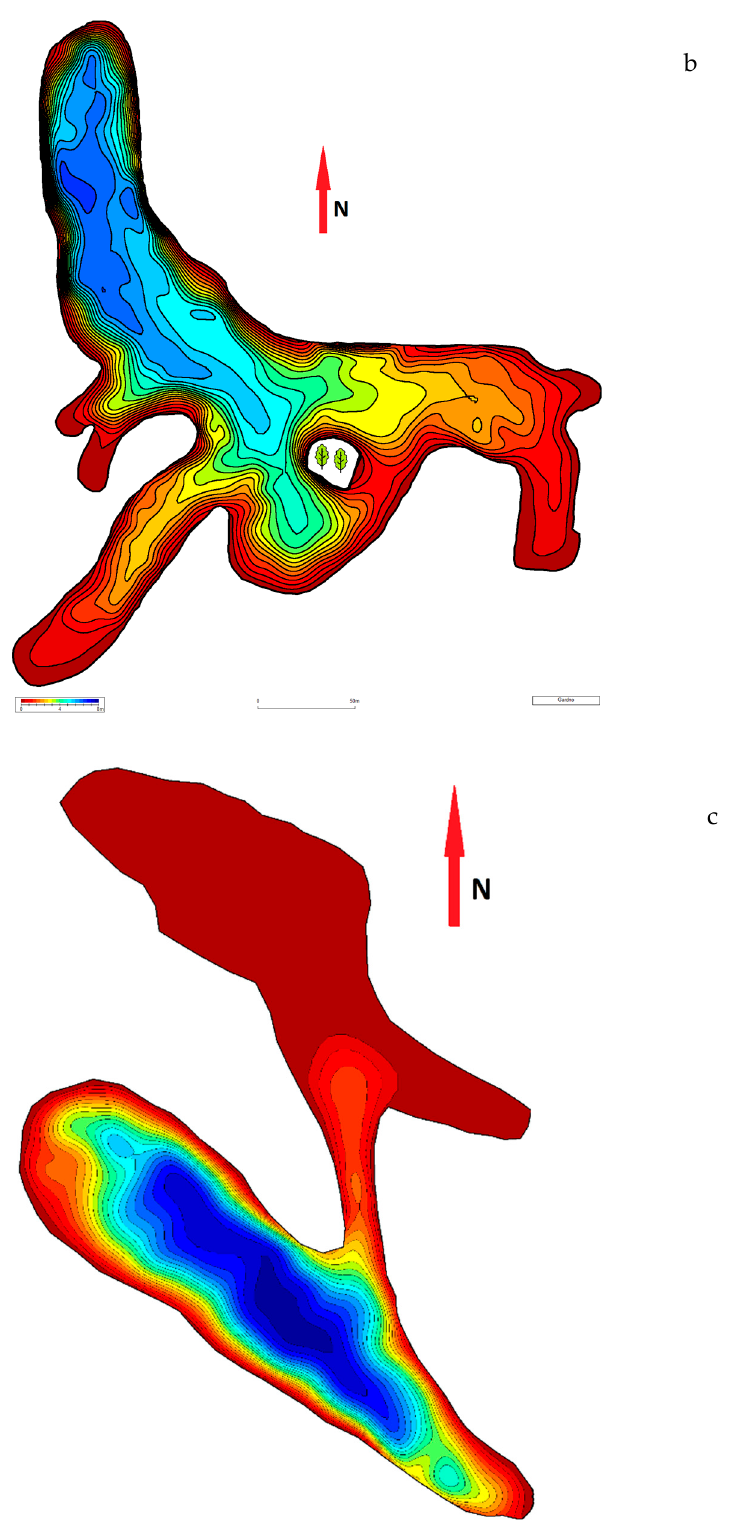
Figure 2. Bathymetry of the studied water bodies (( a )—Domysławskie Lake, ( b )—Gardno Lake, ( c )—Stara Kredownia). Lake Domysławskie is classified as a ‘tench-pike’ fishing lake [12]. It is polymictic, where water masses mix from the surface to the bottom with no thermal stratification.